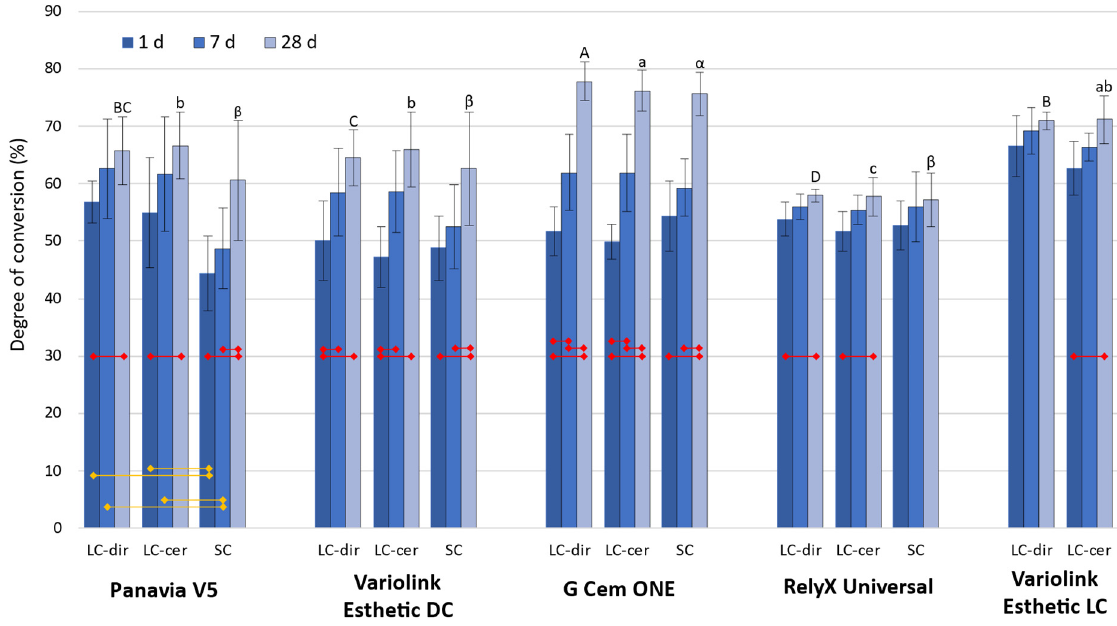
Figure 1. Degree of conversion (mean values ± 1 standard deviation) measured after 1 day, 7 days, and 28 days for the following curing protocols: LC-dir—light-cured directly, LC-cer—light-cured through a ceramic layer, SC—self-cured. Yellow lines at the bottom of the plot denote statistically significant differences among curing protocols. Red lines in the middle of the plot denote statistically significant differences among time points. Same letters above the bars indicate statistically similar values for inter-material comparisons of the degree of conversion values reached 28 days post-cure. These DC values were compared for each of three curing protocols separately, the comparisons within individual curing protocols (LC-dir, LC-cer, and SC) are represented by uppercase, lowercase, and Greek letters,